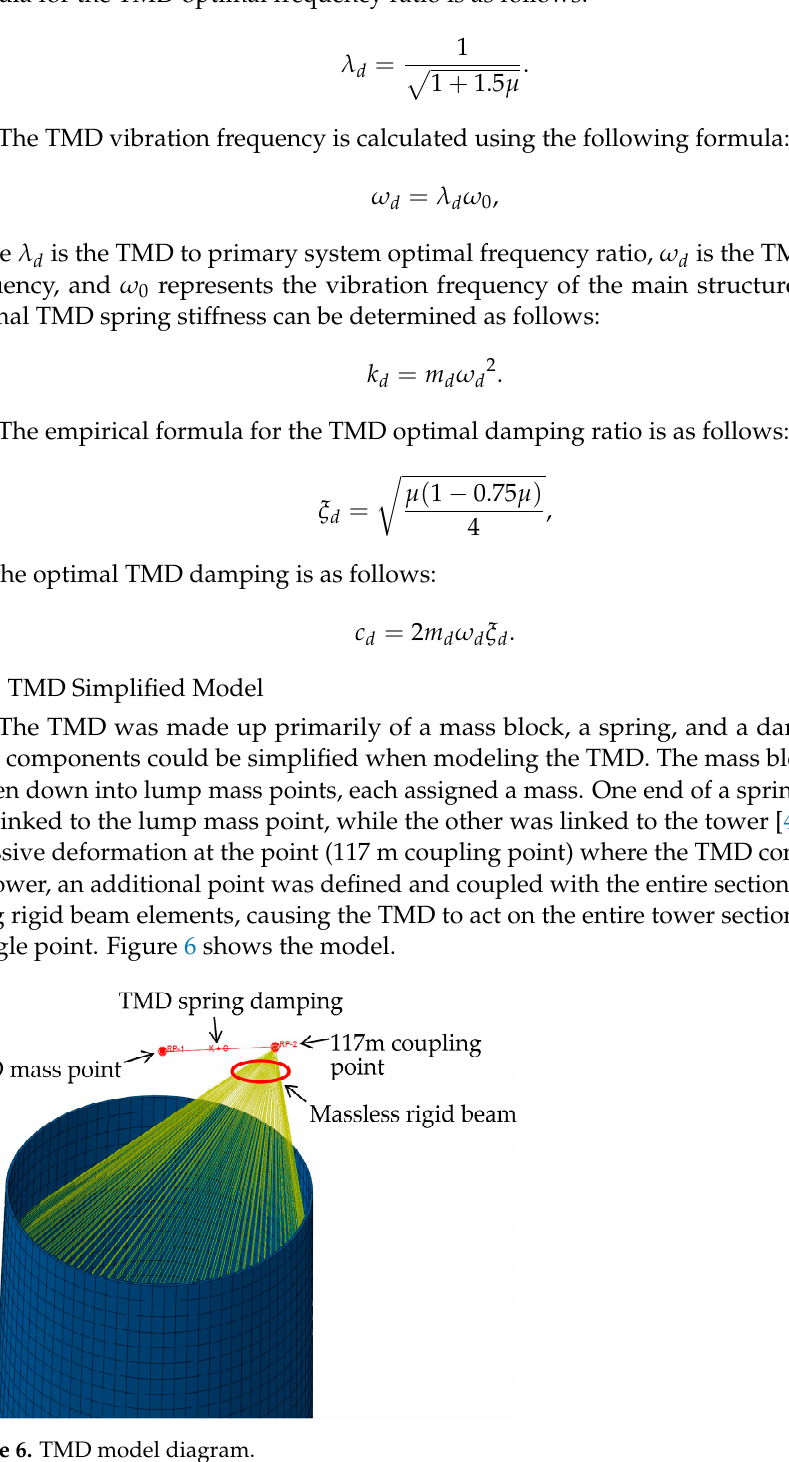
Figure 6. TMD model diagram.